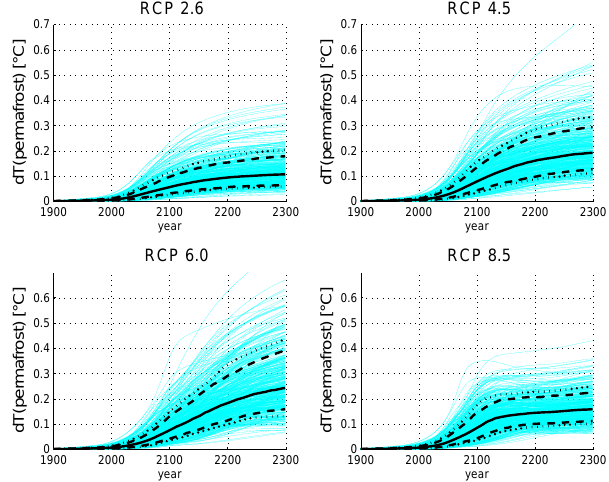
Figure 5. Increase in global average surface air temperature through newly thawed permafrost carbon under various anthropogenic warming scenarios (RCP2.6 to RCP8.5). Blue lines show ensem- ble simulation results based on 500 model runs which account for parameter uncertainty. Black lines show statistical quantiles (solid line: median; dashed lines: 68% range; dotted lines: 80% range). Shown is the temperature feedback as a consequence of CO 2 and CH 4 release from all individual